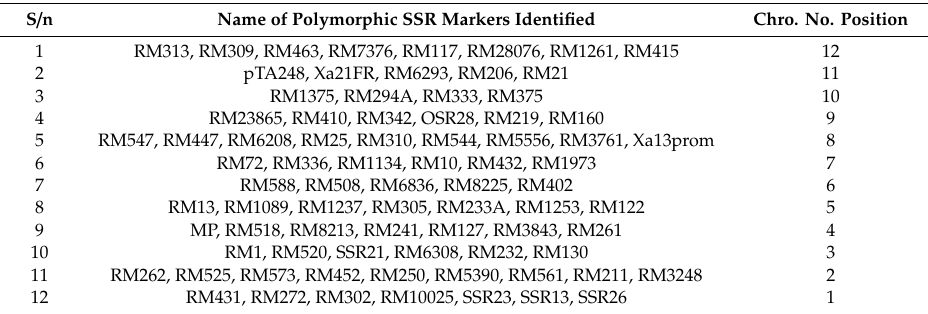
Table 5. SSR markers used for background